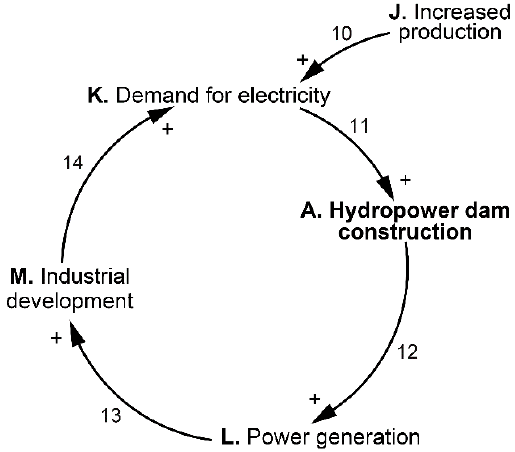
Figure 6. Hydropower influence model for the lower Mekong Basin. Details of the variables J to N and the causal links 10 to 14 for Figure 6 are defined in Tables 2 and 4. Table 4. Definitions of variables and causal links in Figure 6 and later figures, following on from data in Table 3.